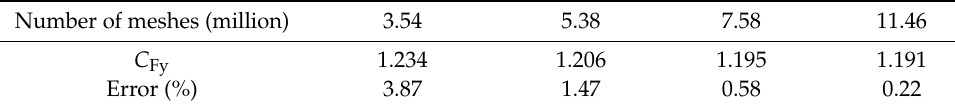
Figure 7. Boundary conditions of the computation domain. Table 4. C Fy values for different numbers of meshes.